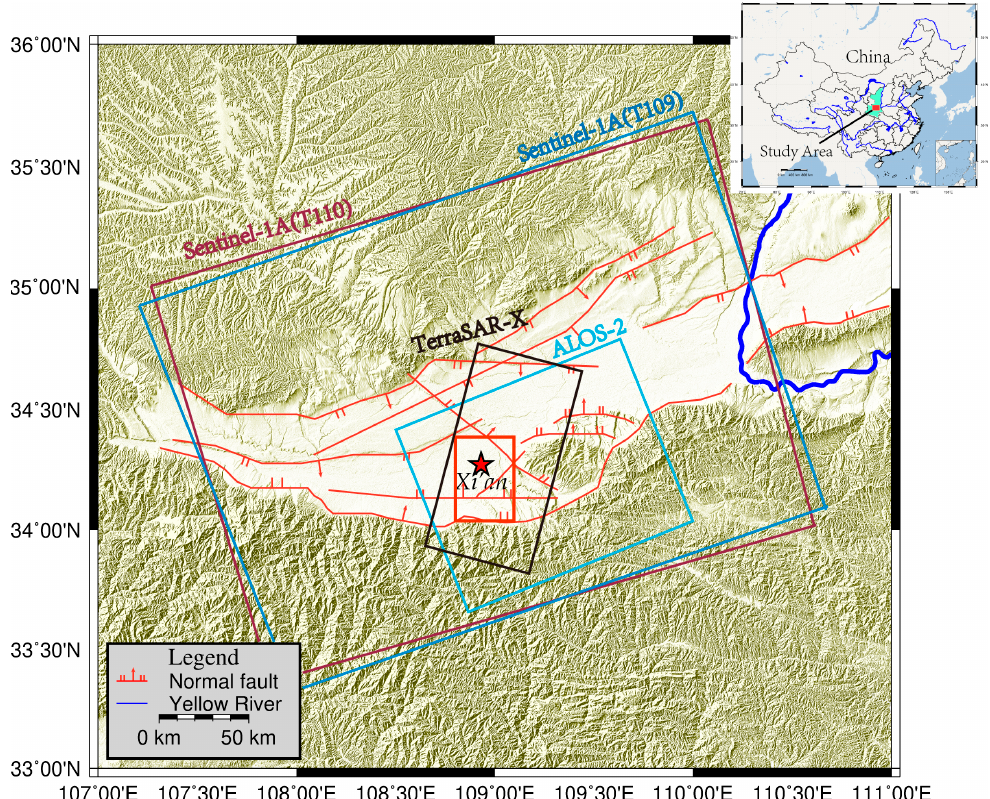
Figure 1. Study area and SAR data coverage used in this study. Different SAR tracks are represented by solid boxes with different colors. The red rectangle indicates the study region of Xi’an.